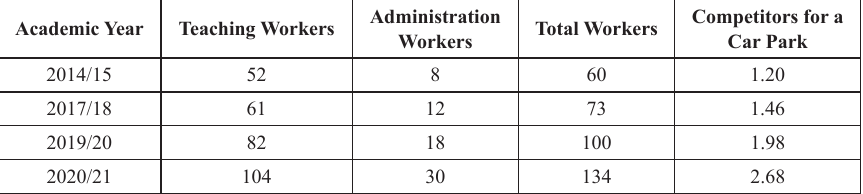
Table 1. Increase in the number of employees at the University “Kadri Zeka” and the number